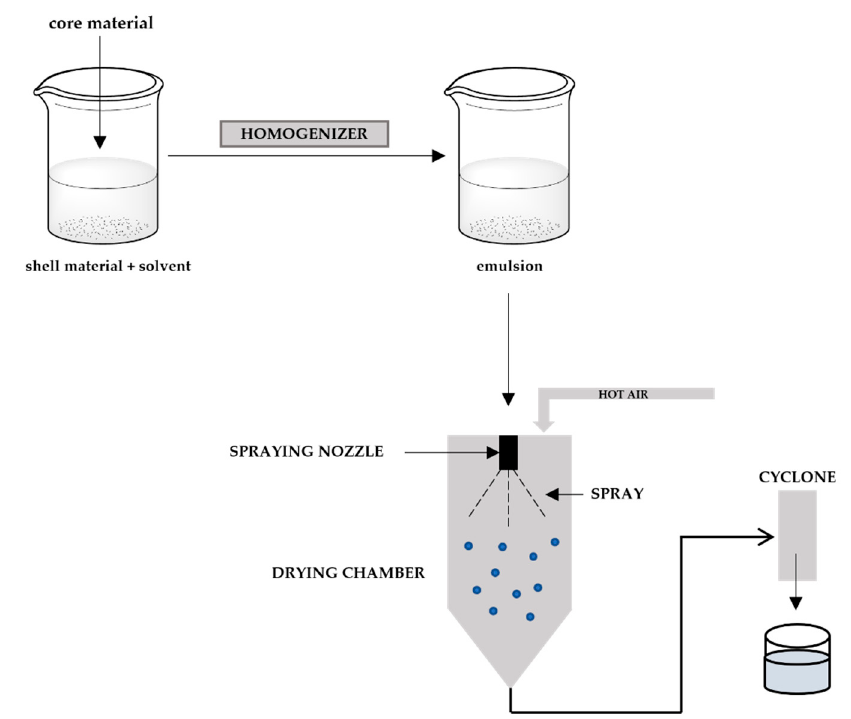
Figure 12. Schematic representation of spray drying.